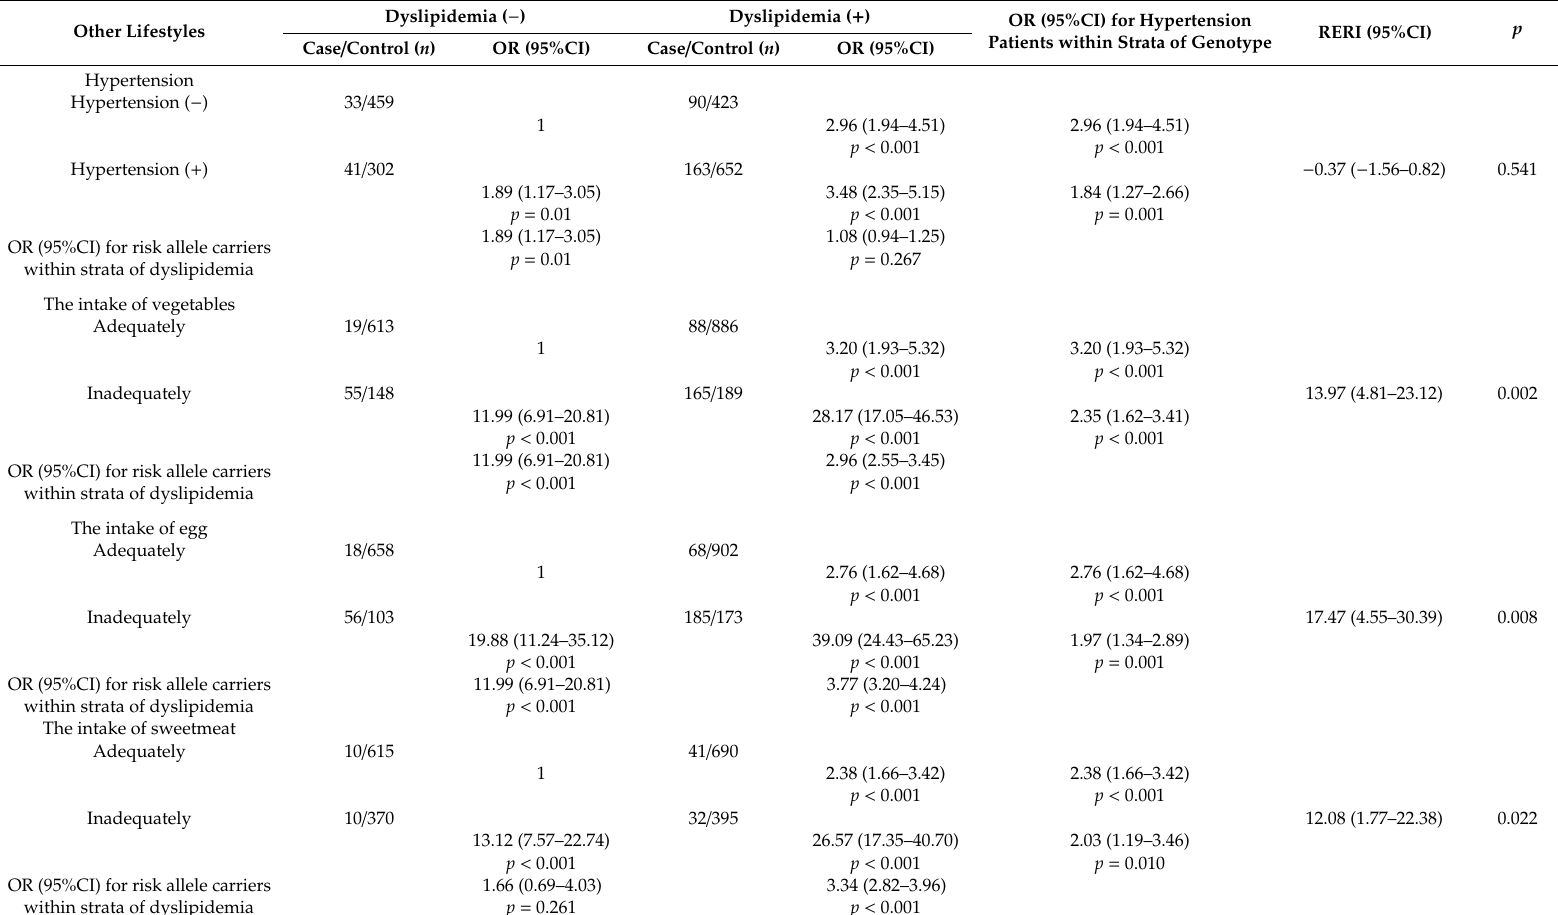
Table 5. Interactions between dyslipidemia and hypertension / other lifestyles for the risk of